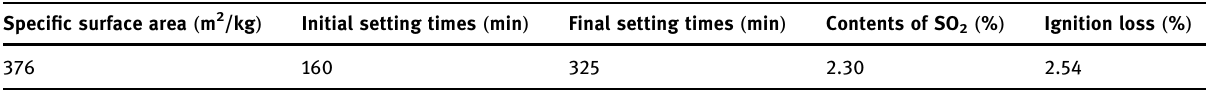
Table 3: Properties of cement Speci fi c surface area ( m 2 /kg )